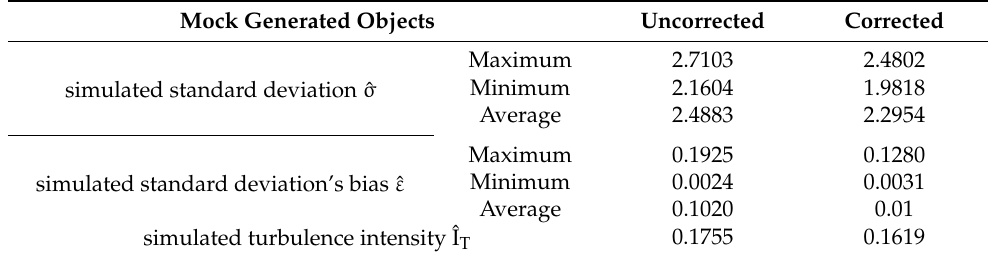
Table 6. Parameters’ contrast between being corrected and uncorrected.